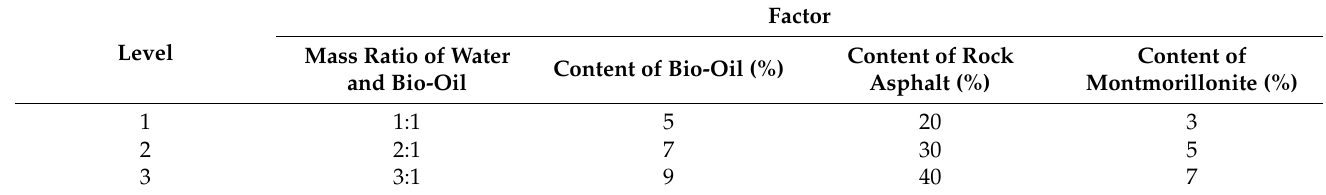
Table 5. Factors and